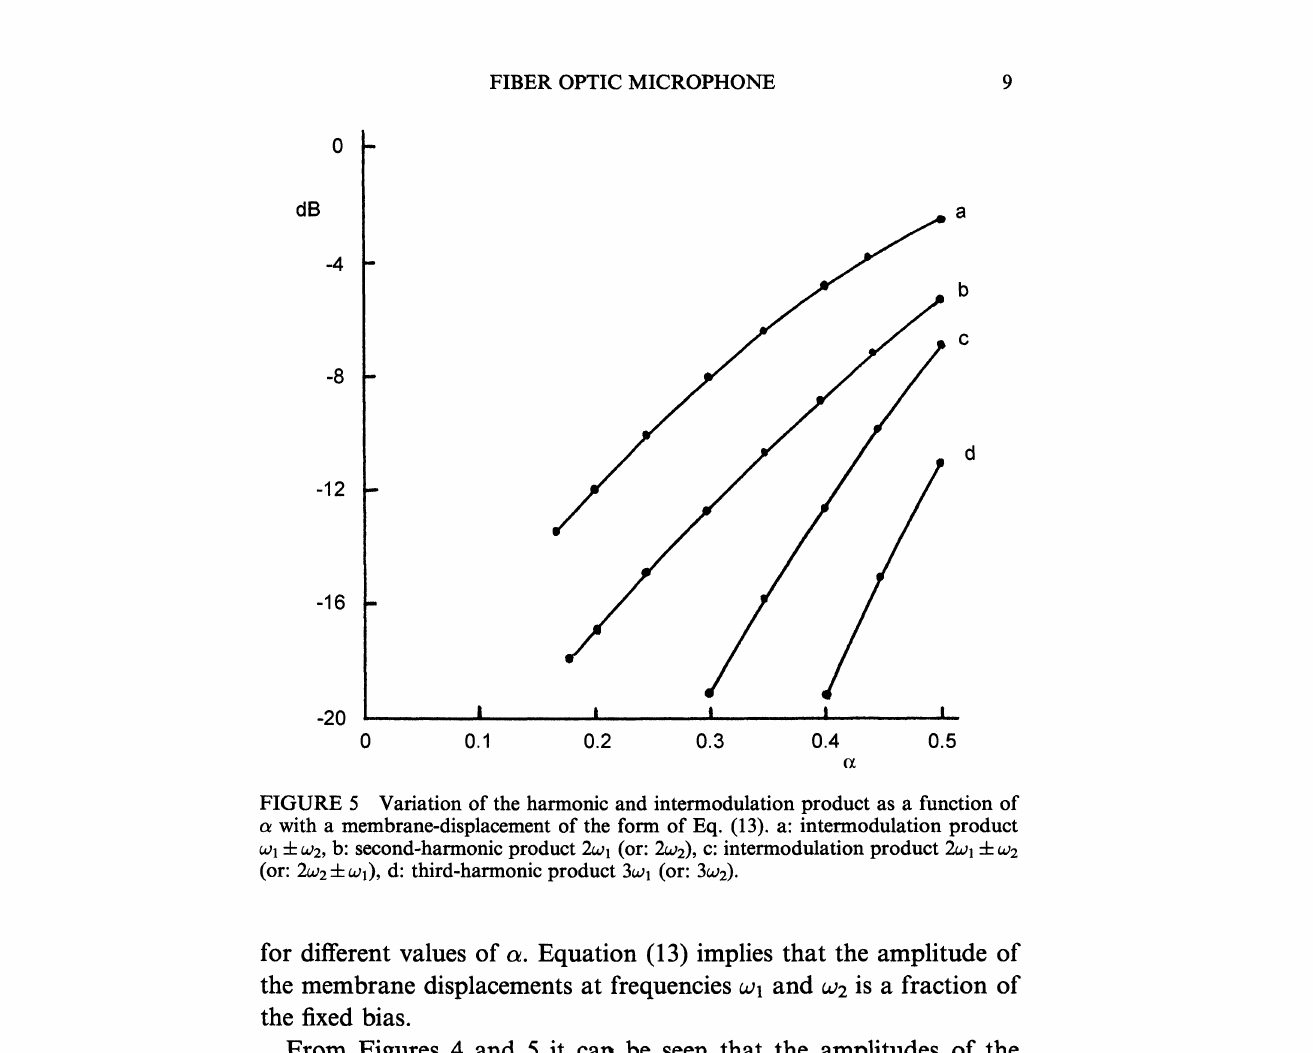
FIGURE 5 Variation of the harmonic and intermodulation product as a function of a with a membrane-displacement of the form of Eq. (13). a: intermodulation product 0. -1" 0.12, b: second-harmonic product 2 (or: 22) C: intermodulation product 2wl 4-2 (or: 2w2 4- wl), d: third-harmonic product 3a)l (or: